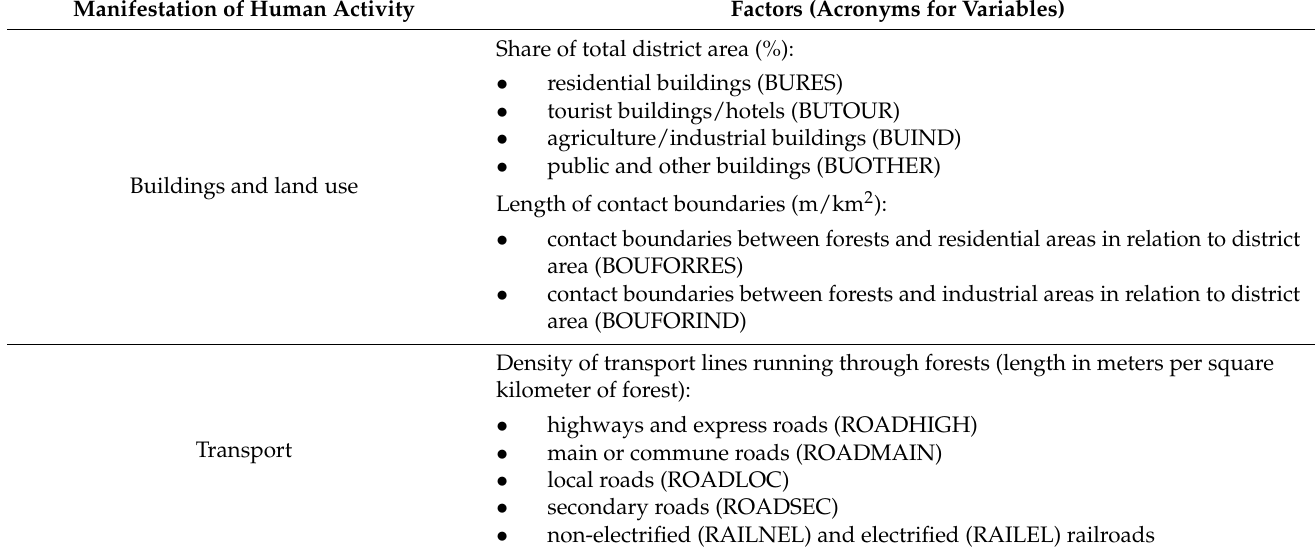
Table 1. Potential determinants of forest fires analyzed in the